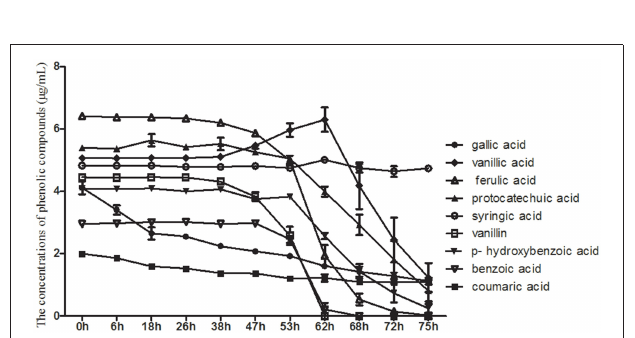
FIGURE 6 | The consumption of phenolic compounds by Talaromyces